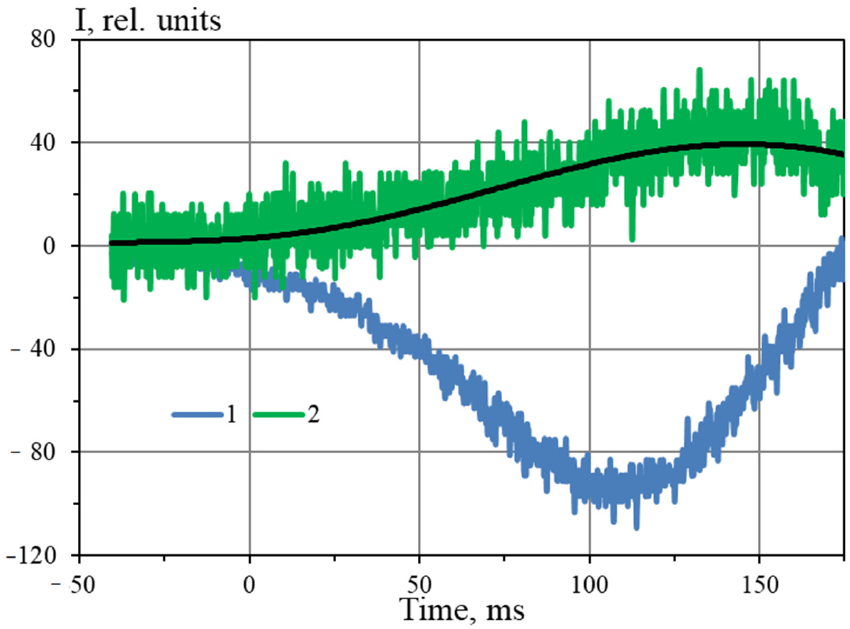
Figure 8. Oscillogram of PMT Signals, (1), and InGaAs Photodetector (2). Gas–argon under pressure of 305 Torr, and lithium layer temperature before reactor start-up is 710 K. The scale is expanded vertically in 10 4 for the line (2).